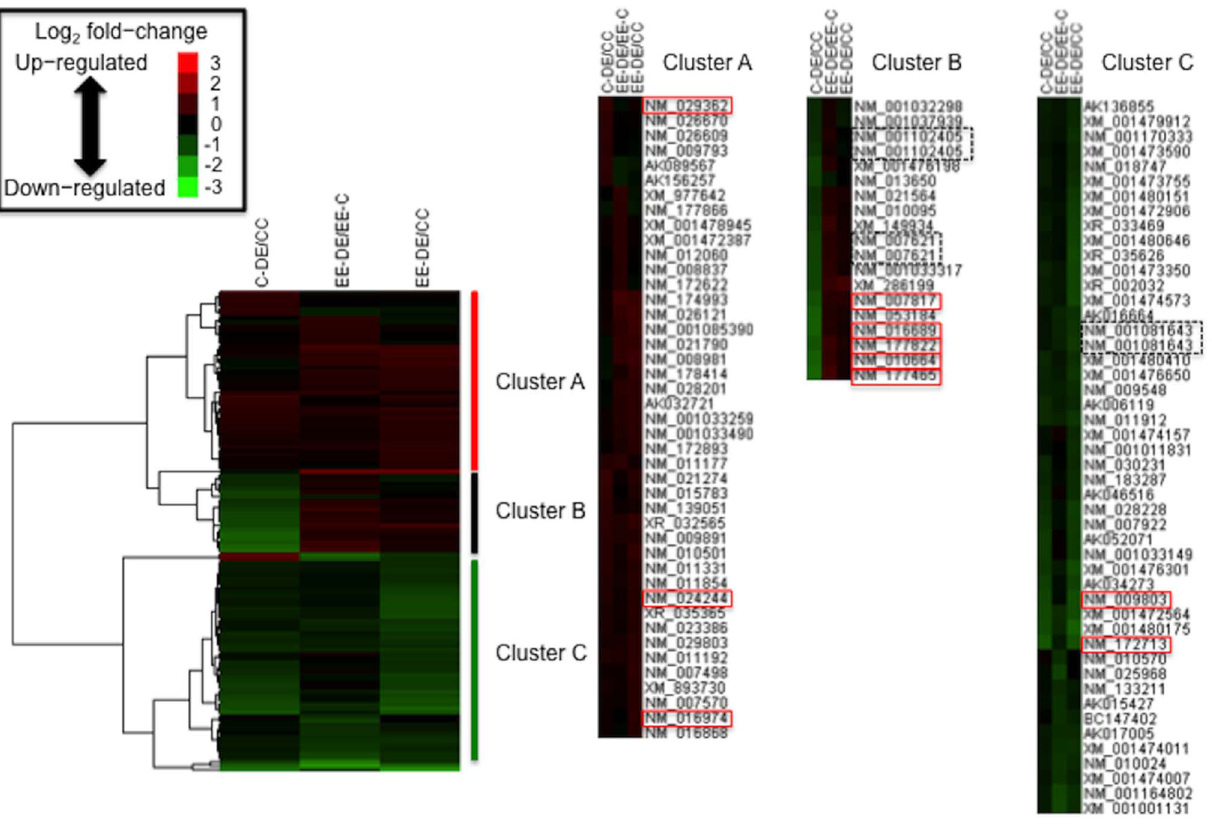
Figure 3. Hierarchical clustering of gene expression data. Within each group, a fold change (C-DE/C-C, EE-DE/EE-C, and EE-DE/C-C) was calculated and log 2 transformed for all 116 spots on the microarray that did not have any missing values. These values were then hierarchically clustered using Euclidean distance metric and complete linkage. The colored images are presented as described: the color scale ranges from saturated green for log 2 ratios –3.0 and below to saturated red for log 2 ratios 3.0 and above. Gene expression profiles were divided into 3 clusters (clusters A, B, and C), and quantitative RT-PCR analysis was performed for genes surrounded by the red line in each cluster. Genes surrounded by black dotted line were the same gene derived from different spots.